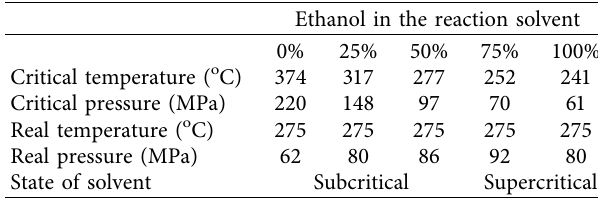
Table 1: The solvent states in reaction conditions [44]. Ethanol in the reaction